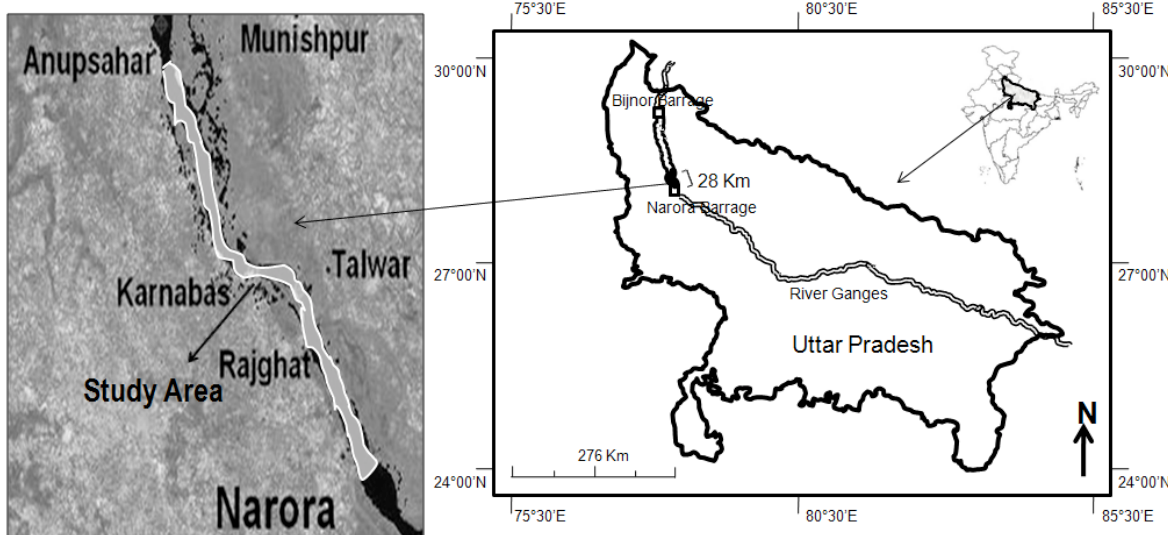
Figure 1. The location of the study area in Uttar Pradesh, India. Source: WWF-India